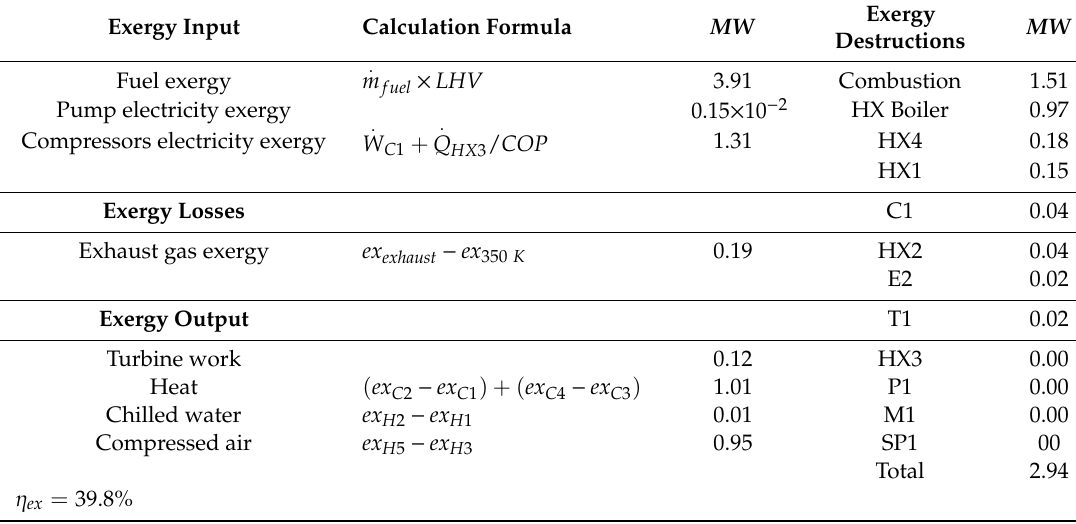
Table 4. Exergy balance for case